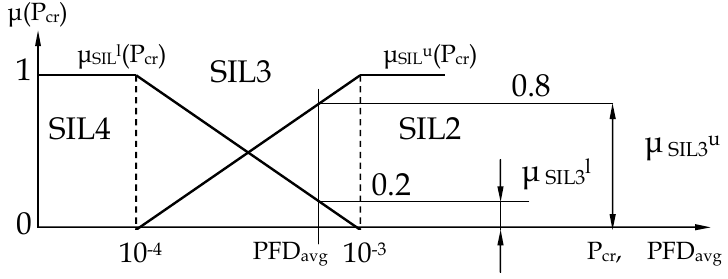
Figure 24. PFD avg evaluation with membership function for SIL3 [10 −4 , 10 −3 ) probabilistic criterion. The result ( µ SIL3l = 0.2 and µ SIL3u = 0.8) for the given PFD avg value is useful for making